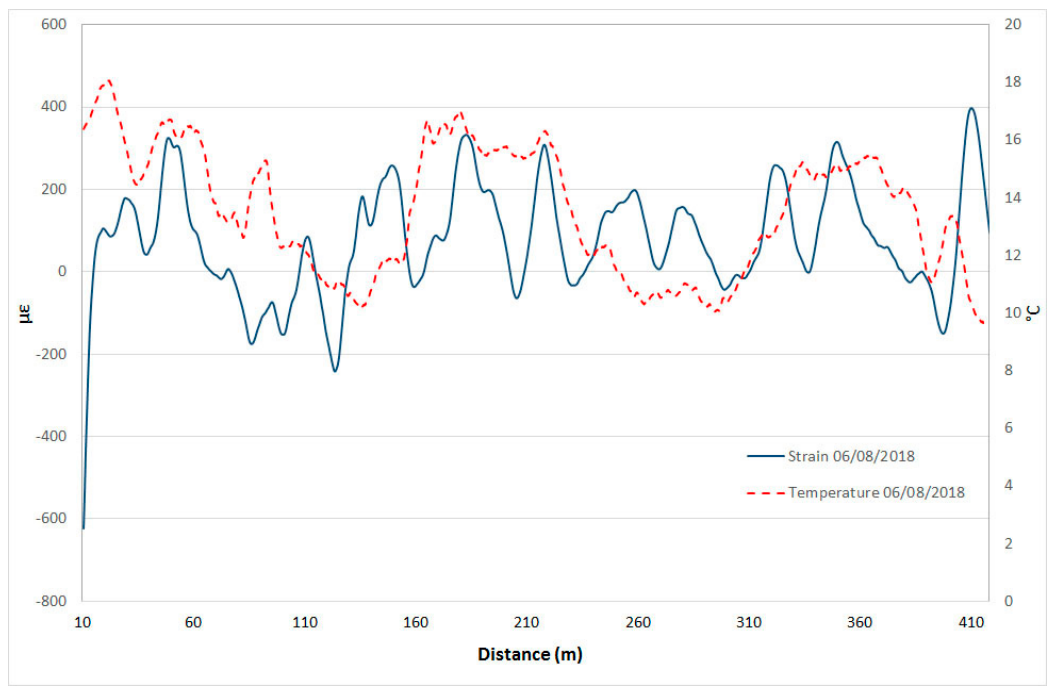
Figure 23. Example of comparison of strain and temperature profiles in summer.